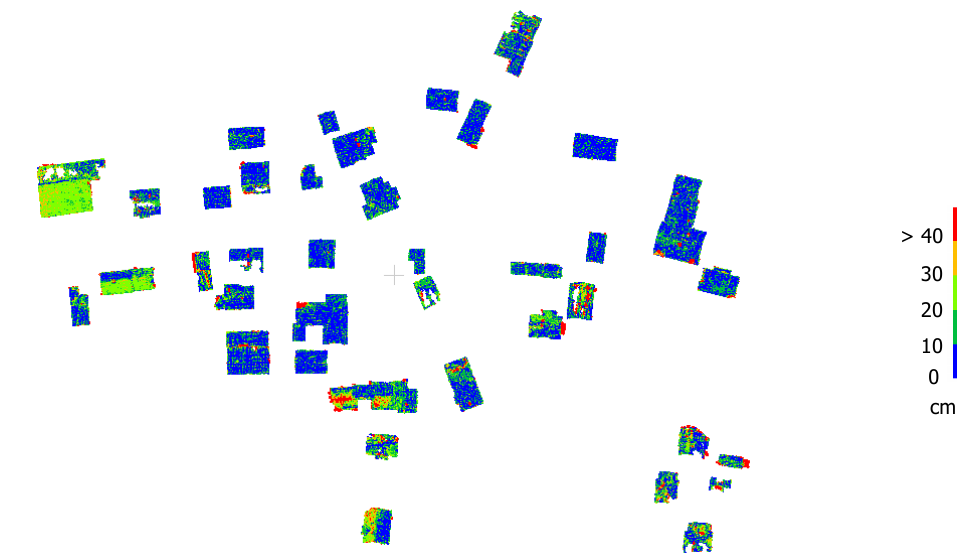
Fig 3.1: Residuals between UAV point cloud and ALS data set.